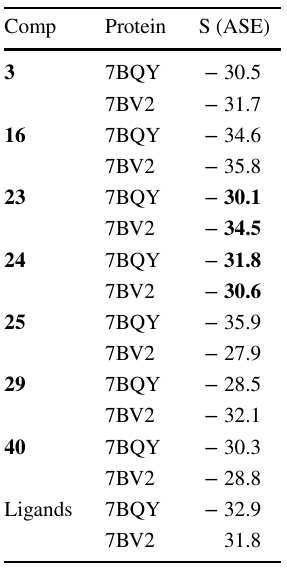
Table 3 MOE binding energies S (Kcal mol −1 ) of best binding pose for compounds 3 , 16 , 23 , 24 , 25 , 29 , 40 and native ligands into 7BQY and 7bV2 (ASE as